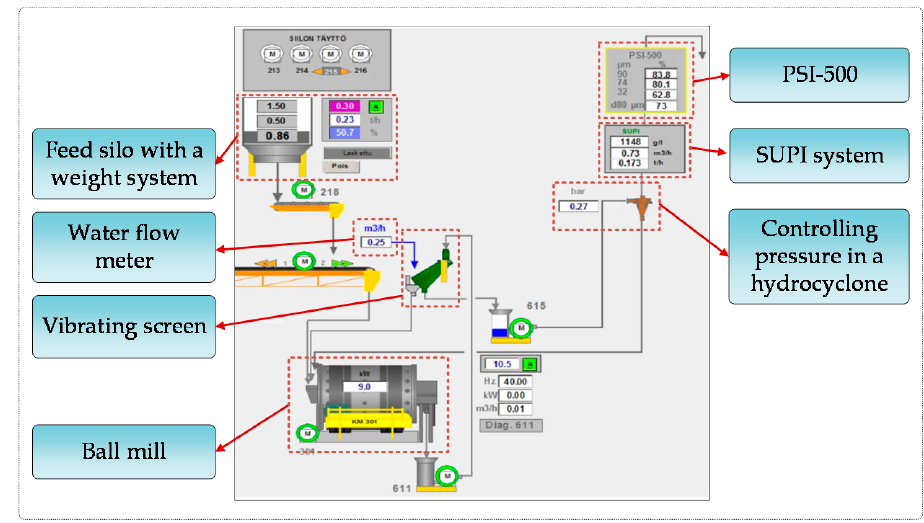
Figure 10. General grinding circuit setup.